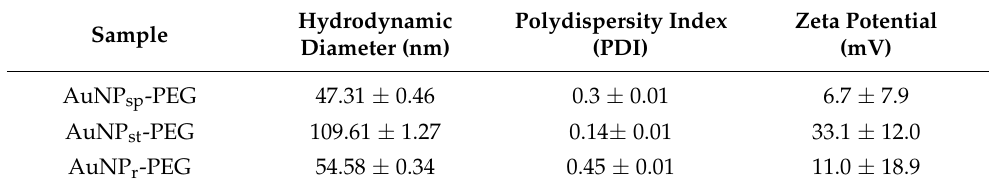
Table 2. Hydrodynamic diameters and zeta potential of AuNP sp -PEG, AuNP st -PEG and AuNP r -PEG.